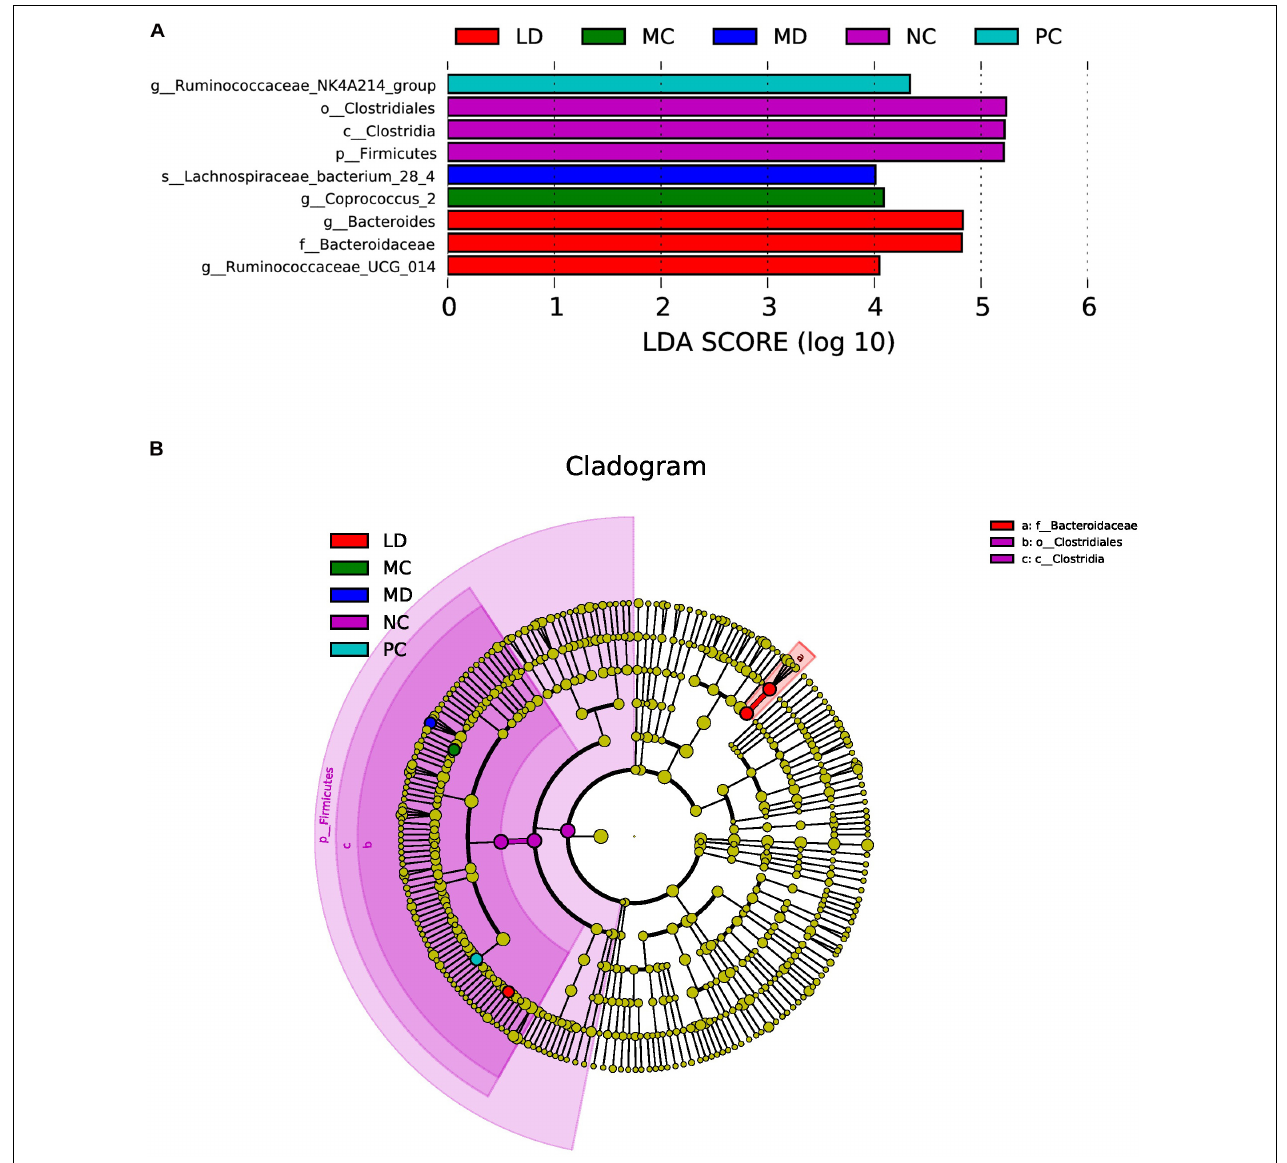
FIGURE 4 | LEfSe analysis of gut bacteria in each group. (A) Linear discriminant analysis (LDA) score plot. Species with an LDA Score threshold > 4 were listed and the length of the bar chart represented the impact of different species. (B) Taxonomy cladogram. The circle of radiation from inside to outside represented the taxonomic rank from phylum to genus (or species) and the diameter of the circles was based on relative